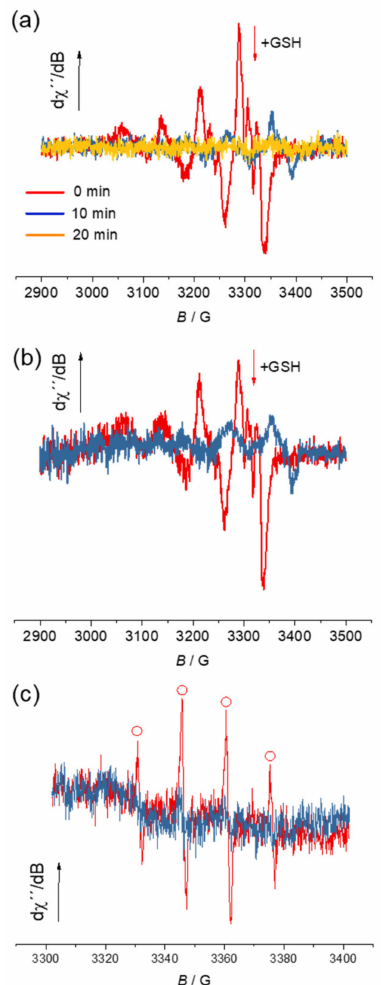
Figure 9. ( a ) EPR spectra of ca. 0.1 mM of 1 in aqueous solution at pH 7 measured before (red trace) and after addition of excess GSH after 10 min (blue trace) and 20 min (dark yellow trace) of the reaction; ( b ) EPR spectra of ca. 0.1 mM of 3 in aqueous solution at pH 7 measured before (red trace) and